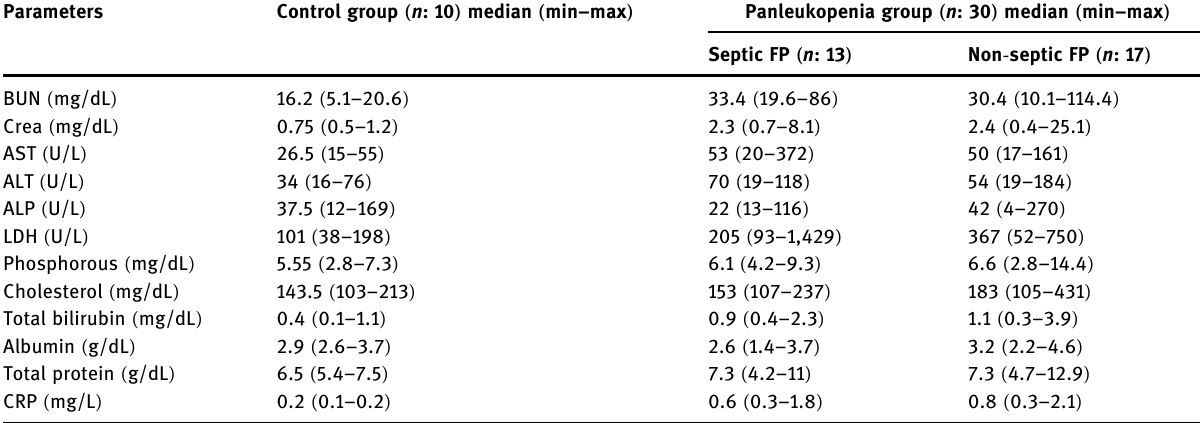
Table 6: Serum biochemistry pro fi ling